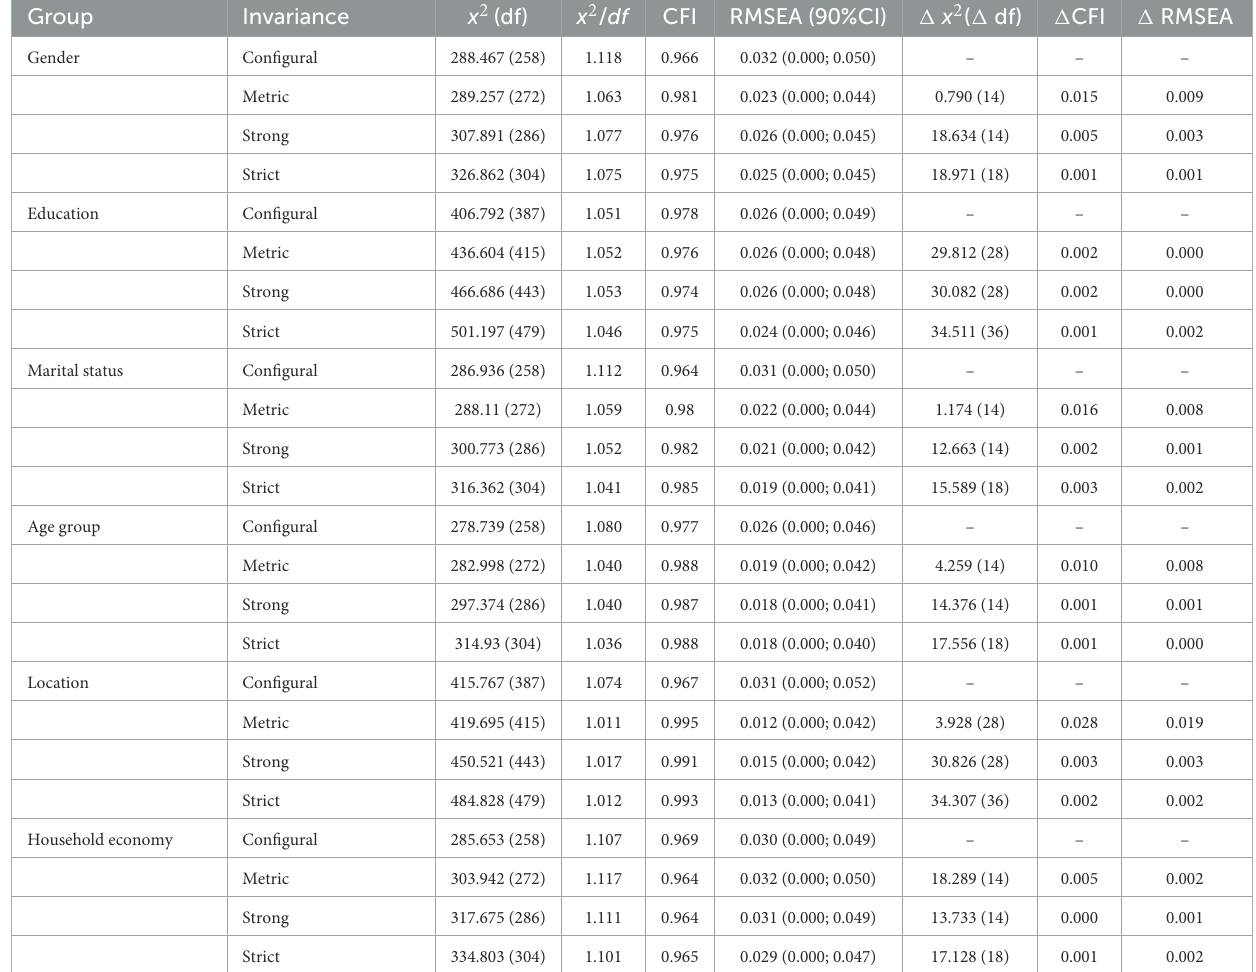
TABLE 5 Measurement invariance in the transactional eHealth literacy questionnaire for the different